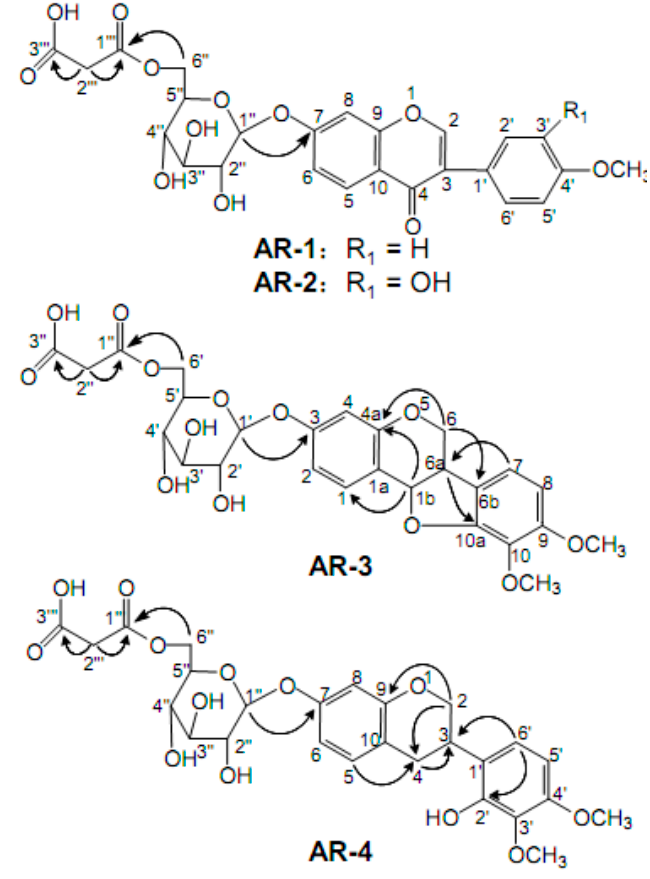
Figure 1. Chemical structures and key HMBC correlations of four malonyl isoflavonoid glycosides isolated from Astragali Radix.